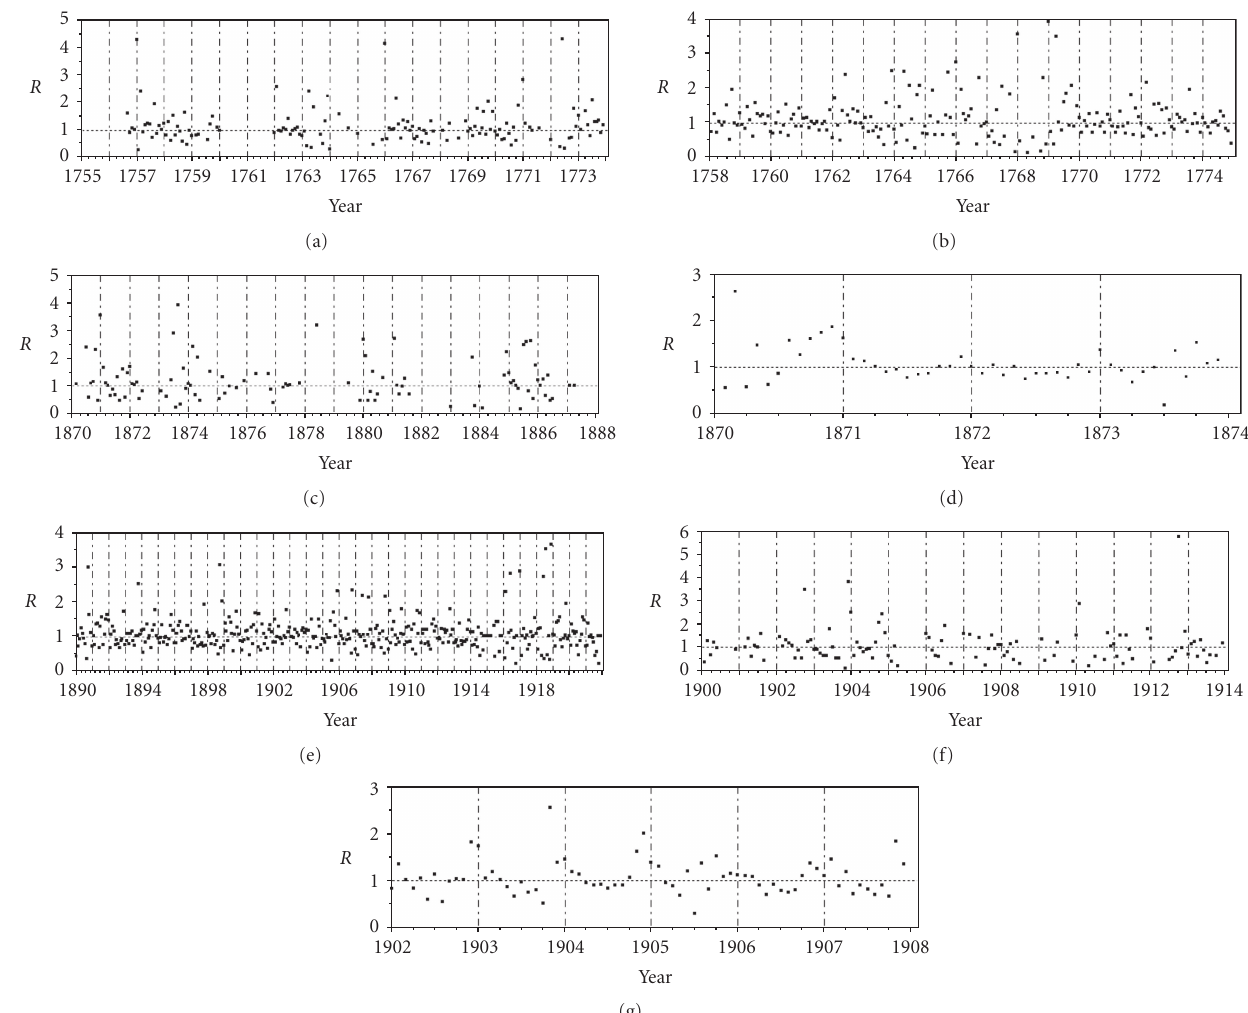
Figure 3: Estimates of the e ff ective reproduction numbers with time, R ( t ). (a)–(f) correspond to locations as chronologically ordered in Figure 1. The horizontal dashed line indicates where the reproduction number is unity. The vertical broken lines represent every January. R ( t ) cannot be estimated where the observed number of cases (or deaths) was 0 and is not shown for such time points. Table 1: Monthly weather patterns and smallpox mortality in Northwest frontier province, India, from 1890–1921. Univariate model Multivariate model ¶ Meteorological element MRR ‡ (95% CI † ) MRR ‡ (95% CI † ) Rainfall (inch) 0.979 (0.952, 1.003) Absolute humidity 0.387 (0.311, 0.481) < .01 ‡ MRR, mortality rate ratio, reflects change in risk of smallpox death per unit (or absolute value) in the meteorological variable in question. † CI, confidence interval. ¶ The multivariate model was also adjusted for the calendar